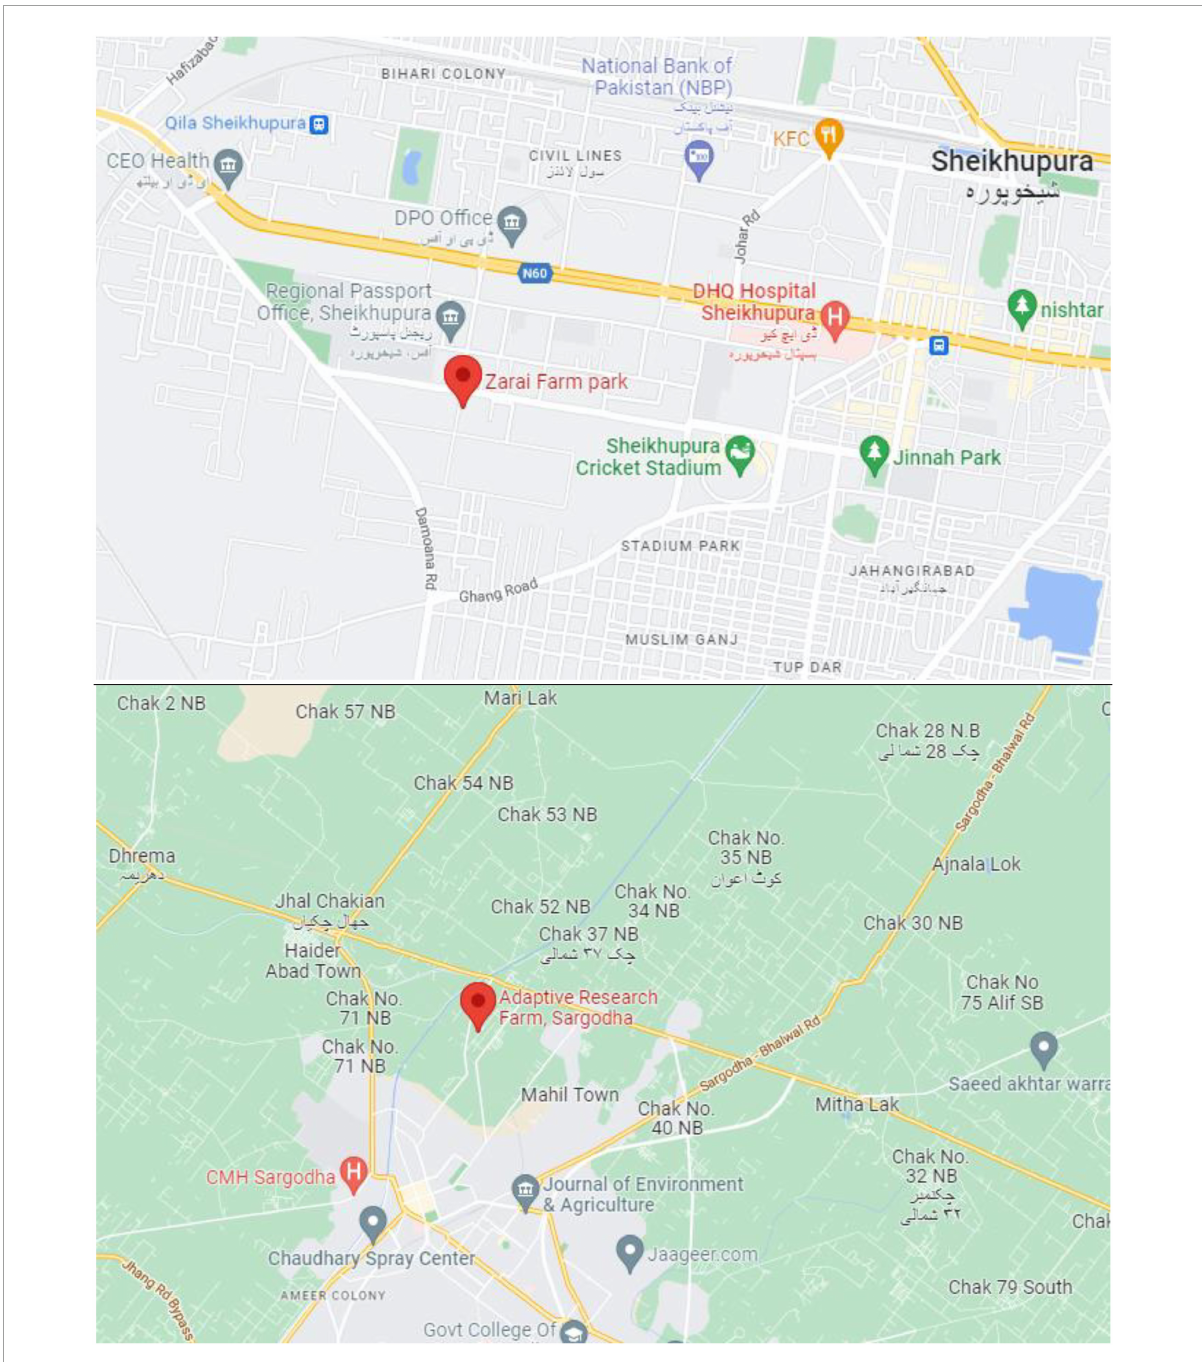
FIGURE1 Geographical map of the study area: Adaptive research farm, Sheikhupura (Zarai Farm Park) and adaptive research arm, Sargodha.